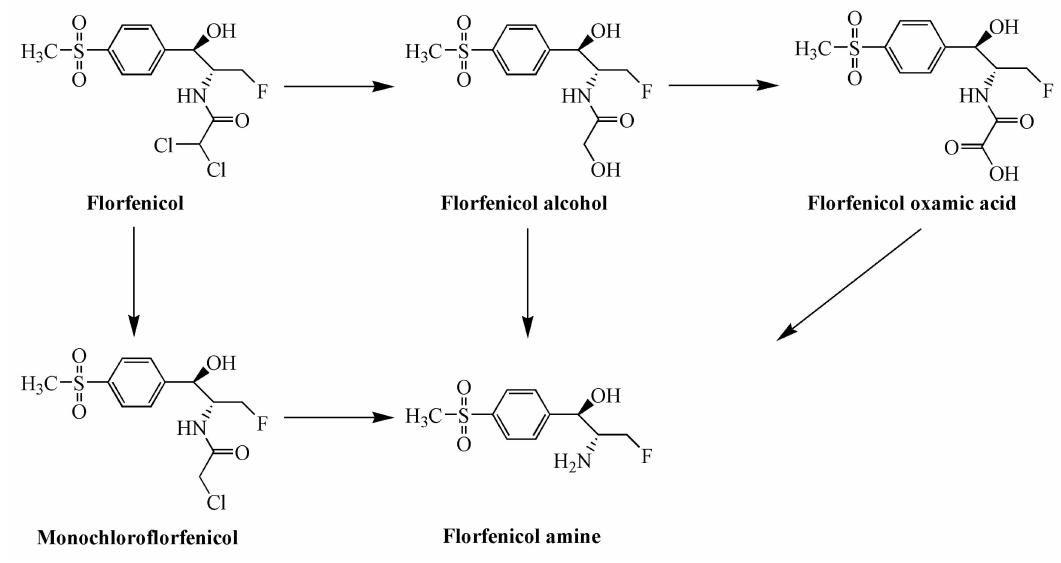
Figure 1. Florfenicol (FF) metabolic